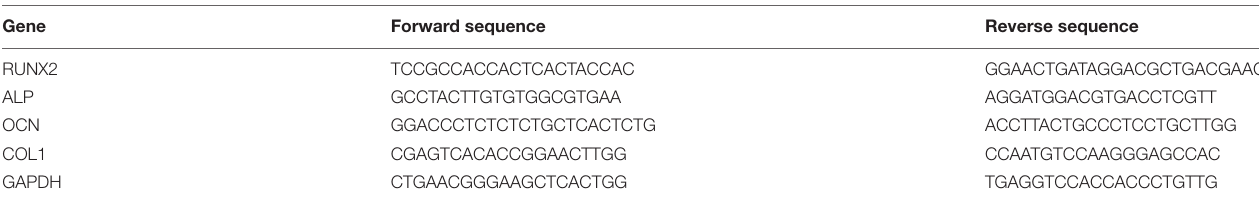
TABLE 1 | Primer sequences used for